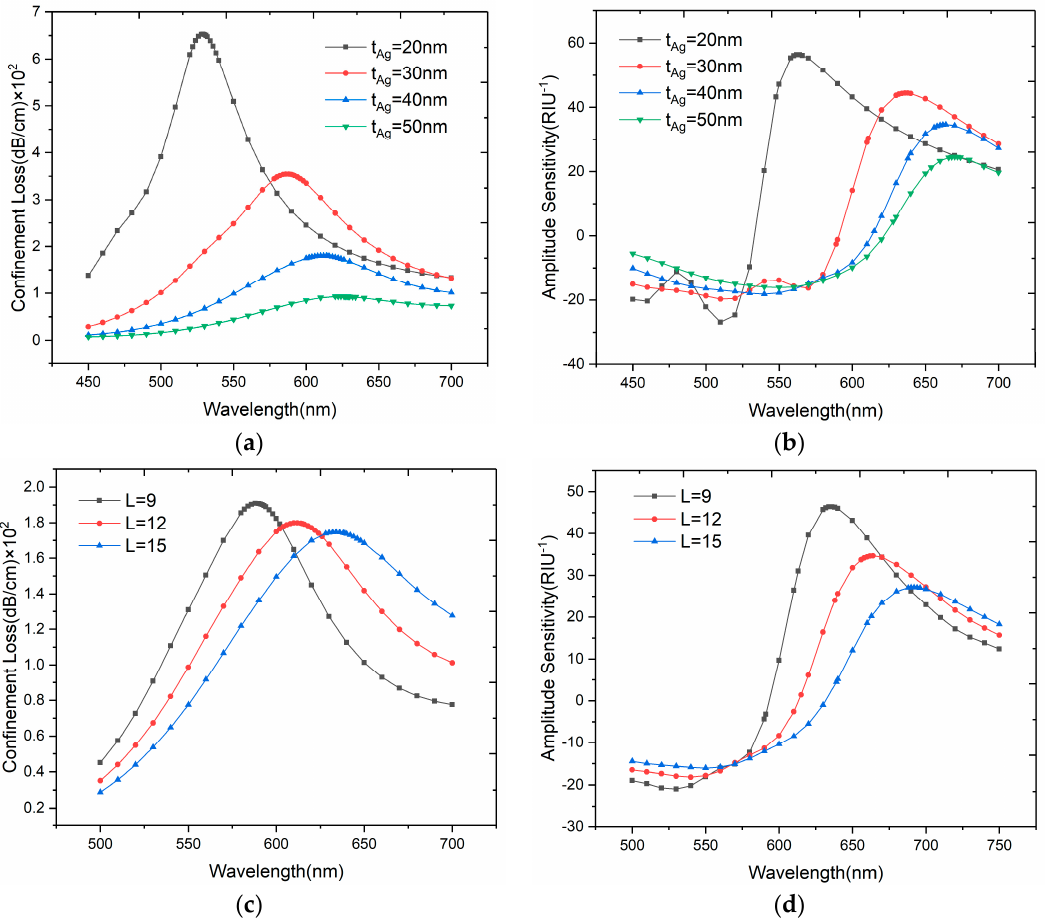
Figure 7. ( a ) Loss spectra of the designed sensor when t Ag = 20, 30, 40 and 50 nm with n a = 1.33; ( b ) Amplitude sensitivities of the proposed sensor when t Ag = 20, 30, 40 and 50nm with n a = 1.33; ( c ) Loss spectra of the designed sensor when L = 9, 12 and 15 with n a = 1.33; ( d ) Amplitude sensitivities of the proposed sensor when L = 9, 12 and 15 with n a = 1.33.